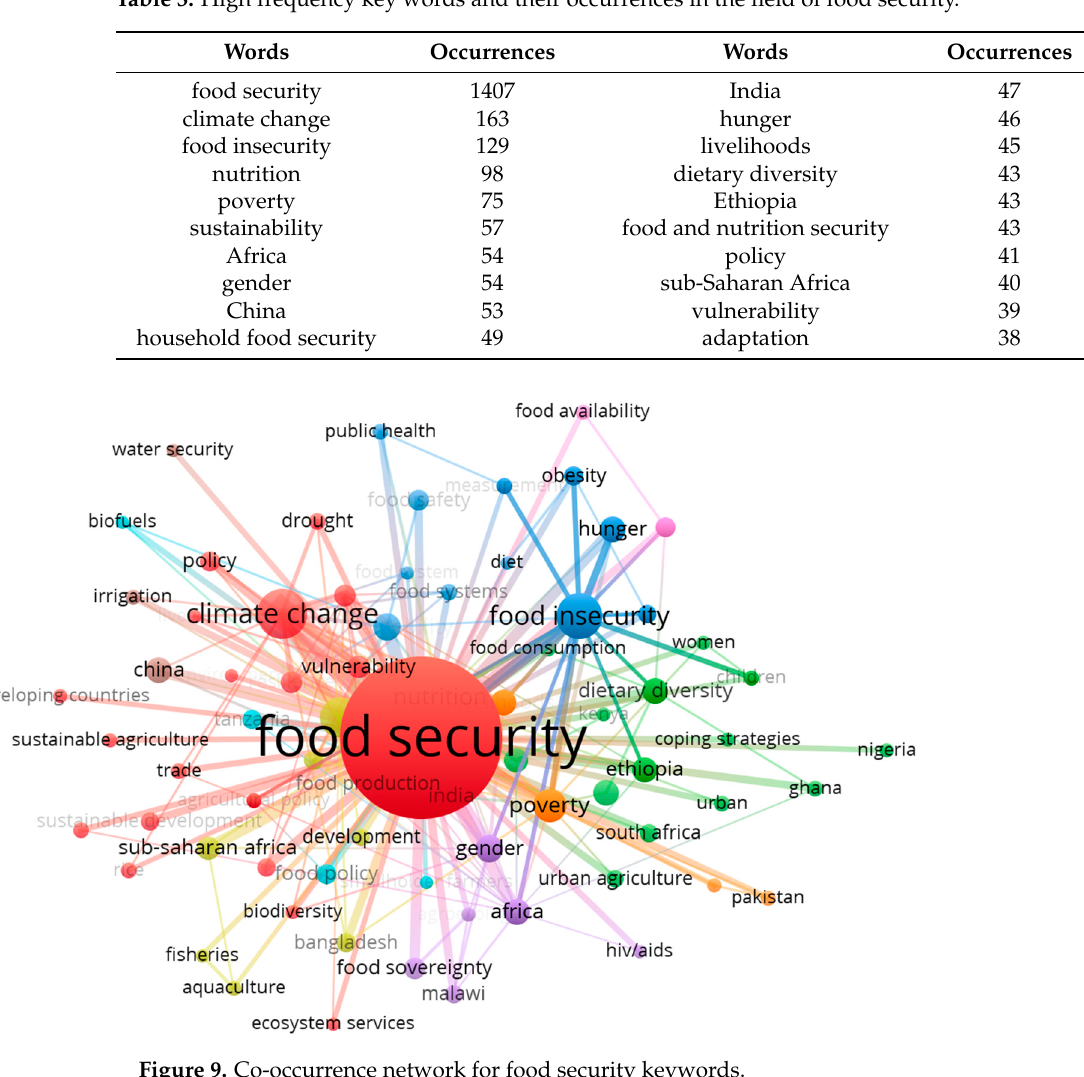
Table 3. High frequency key words and their occurrences in the field of food security.